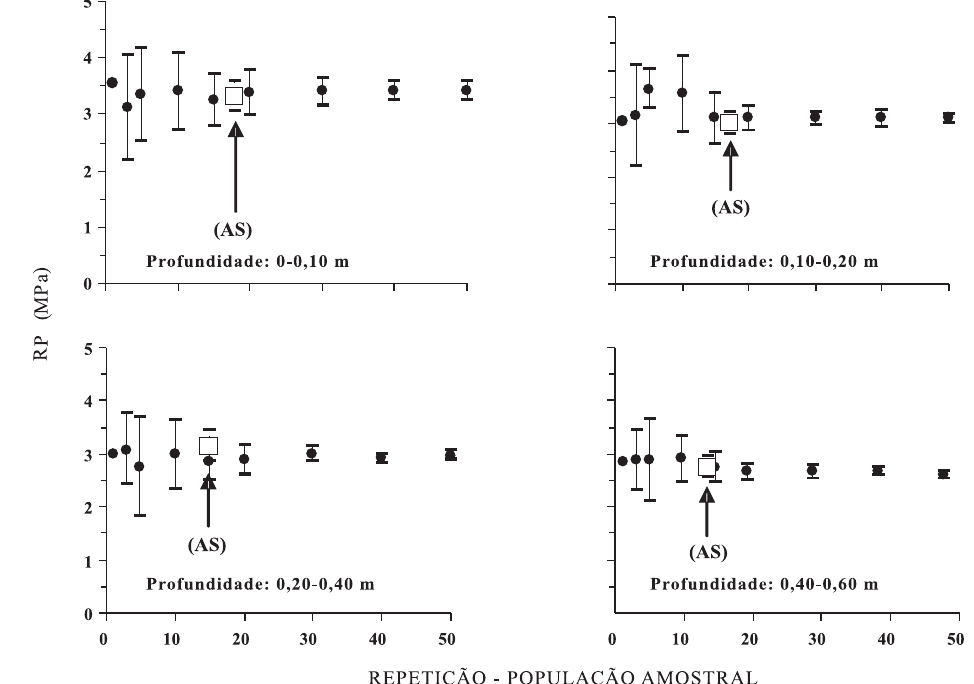
Figura 2. Valores médios e intervalo de confiança (95 %) da resistência do solo à penetração (RP) função da amostragem ao acaso (clássica) e da amostragem sistemática (AS), com penetrômetro de impacto em diferentes profundidades de um Latossolo Vermelho eutroférrico sob cultura